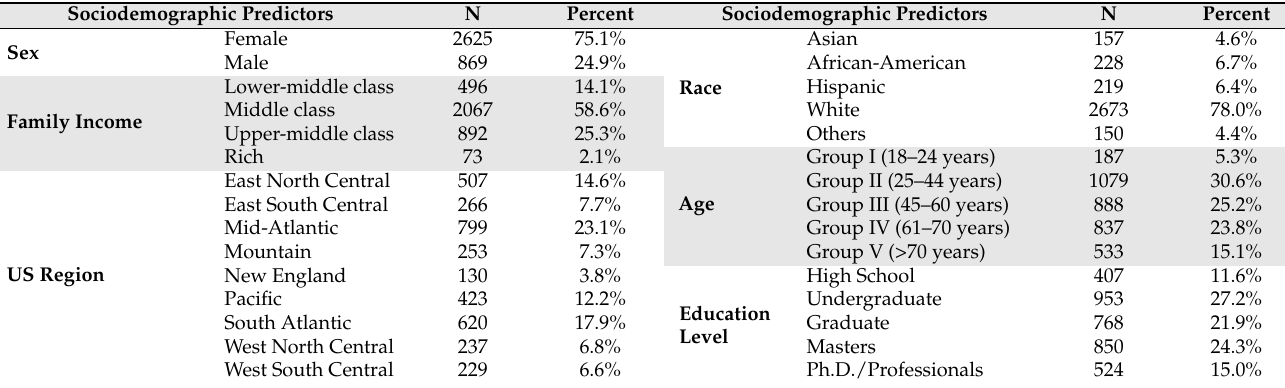
Table 1. Characterization of the sociodemographic predictors of COVID-related perceptions. Sociodemographic